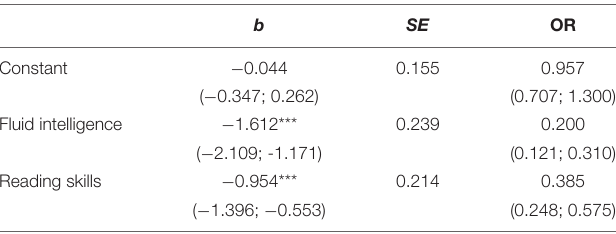
TABLE 3 | Coefficients with 95%-CI of the model predicting whether a student has been diagnosed with